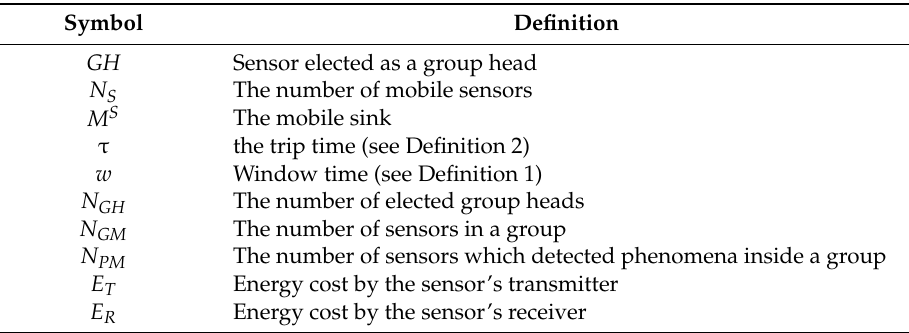
Table 1. Definitions of the frequently used symbols.